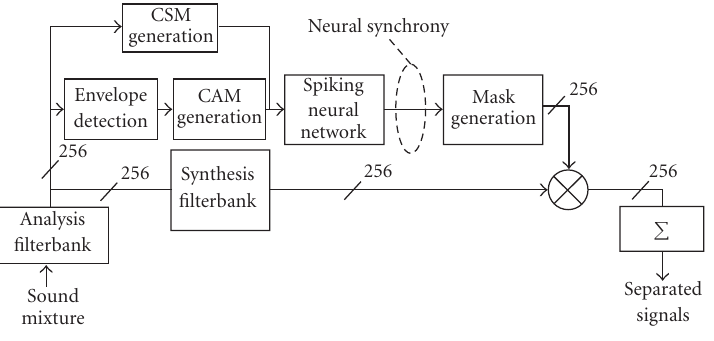
Figure 1: Source separation system. Depending on the sources’ auditory images (CAM or CSM), the spiking neural network generates the mask (binary gain) to switch on/o ff —in time and across channels—the synthesis filter bank channels before final summation.